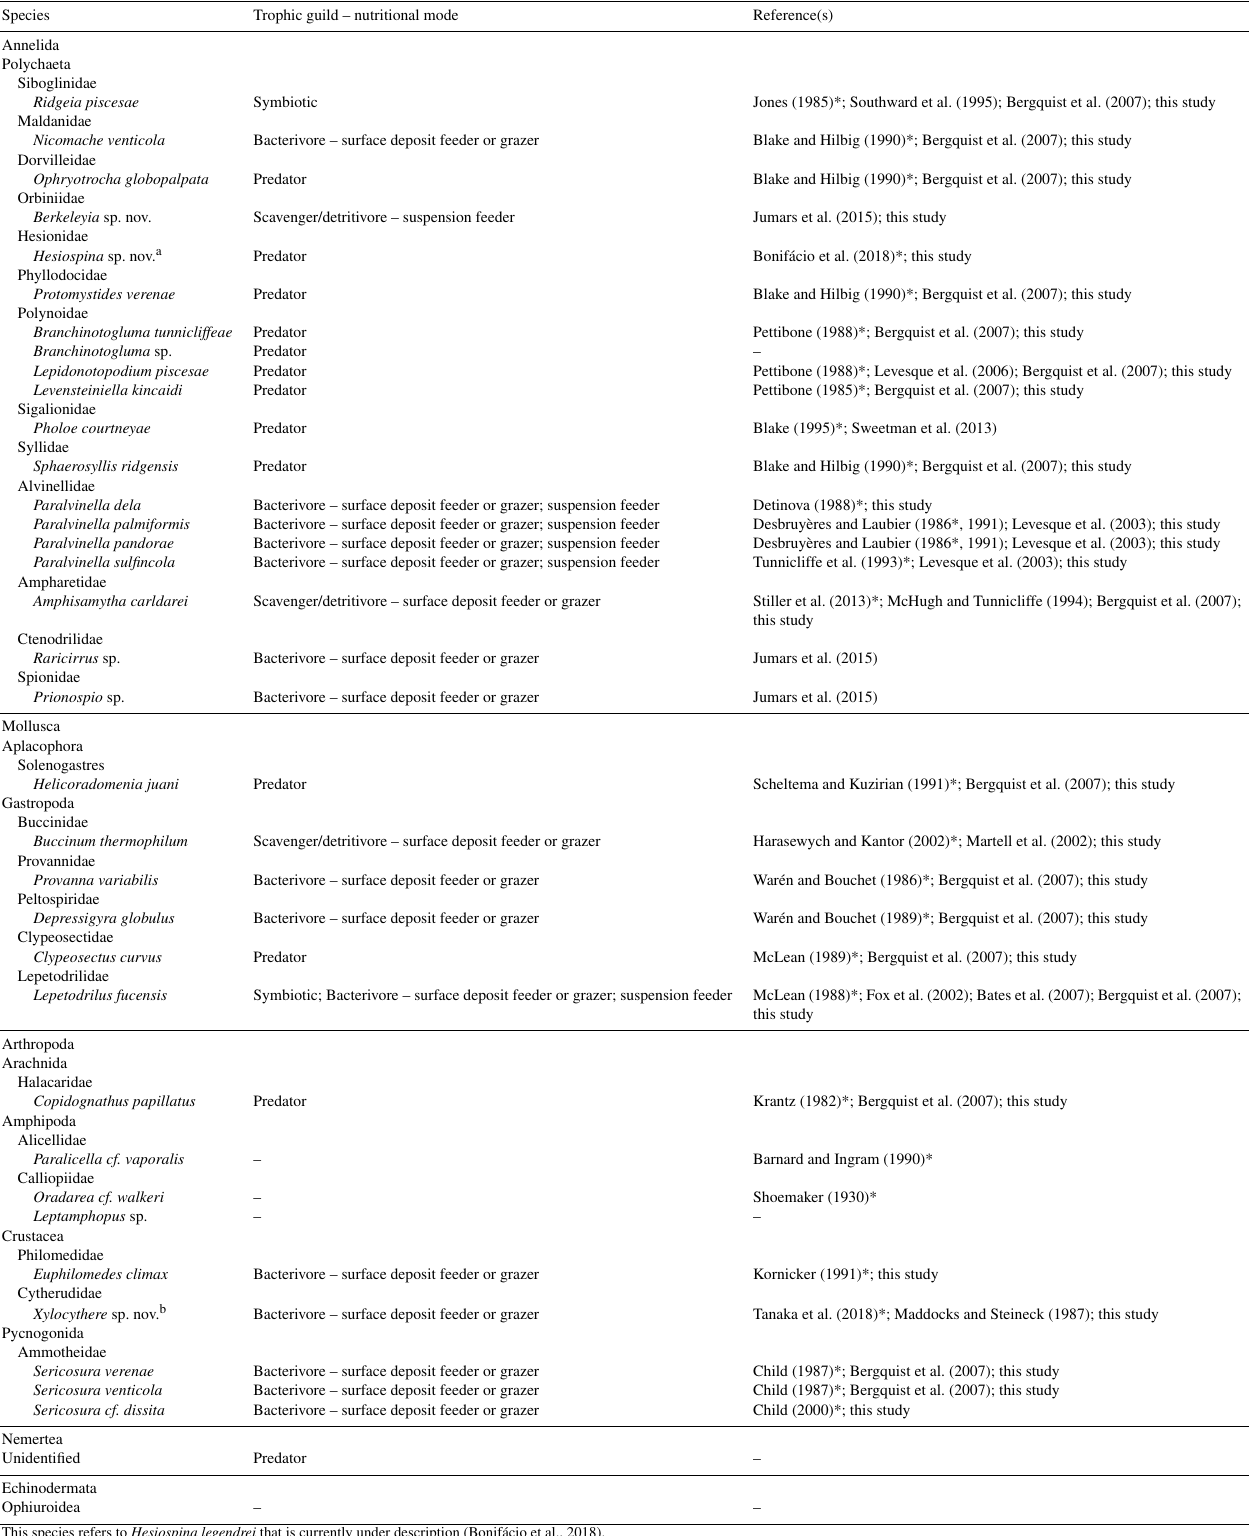
Table 1. Trophic guild and nutritional modes of macrofaunal species associated with the Ridgeia piscesae tubeworm assemblages of the Grotto hydrothermal edifice (Main Endeavour Field, Juan de Fuca Ridge). An asterisk (*) marks the original description of the species.